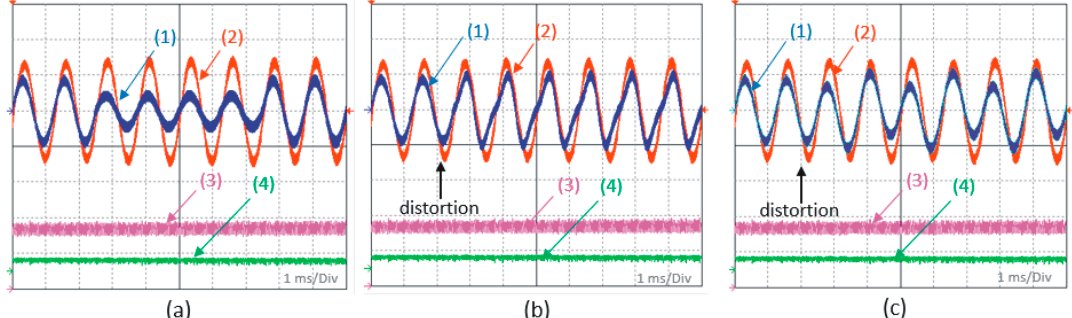
Figure 16. Performance of the closed-loop control system. Waveforms of (1) on-board 400 Hz grid voltage, (2) the grid current, (3) the photovoltaic voltage and (4) the photovoltaic current: ( a ) in case of 50% grid voltage sag, ( b ) in the presence of the interharmonics and ( c ) in the presence of subhar- monics.